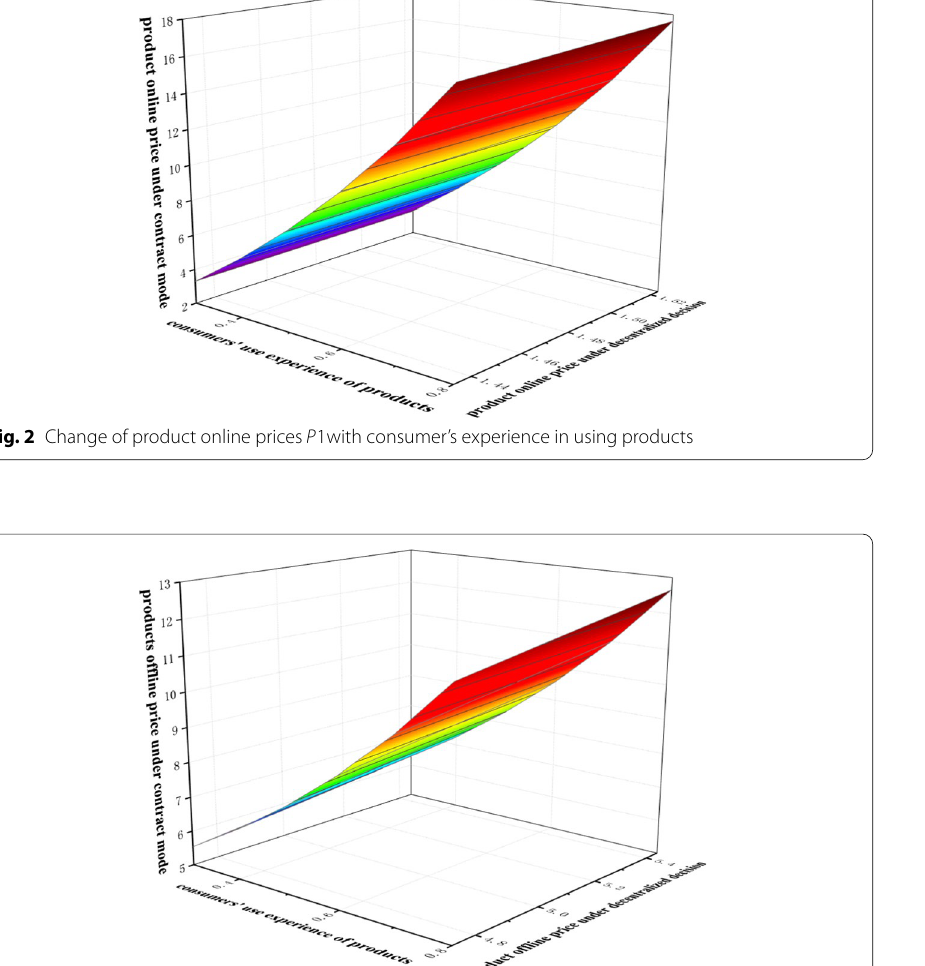
Fig. 3 Change of product offline price P 2 with consumer’s experience in using